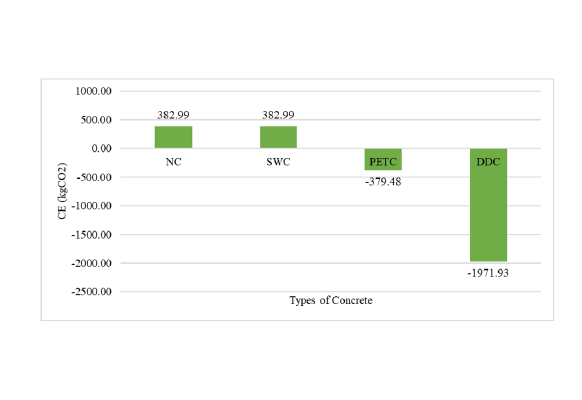
Fig. 7. Comparison of CE Value for 1 m 3 Concrete.